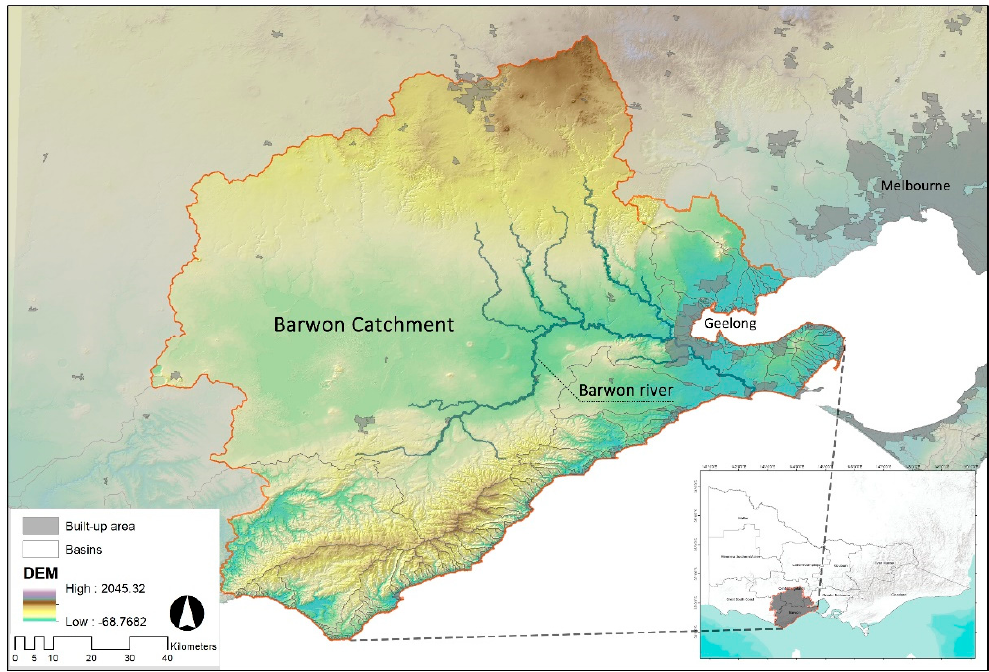
Figure 1. Situation of the study cases.